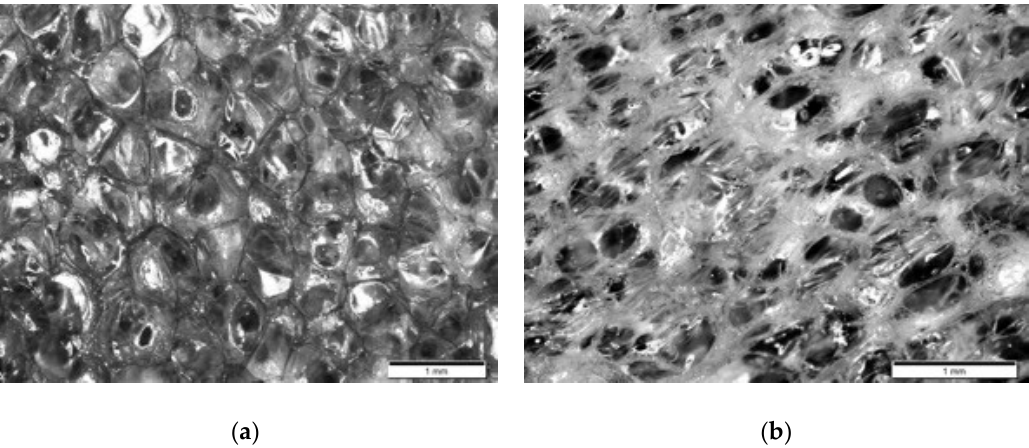
Figure 13. Optical images of the cross-section of the original foam ( a ) and the foam recovered from programming to 80% at room temperature ( b ). The scale bar is 1 mm.